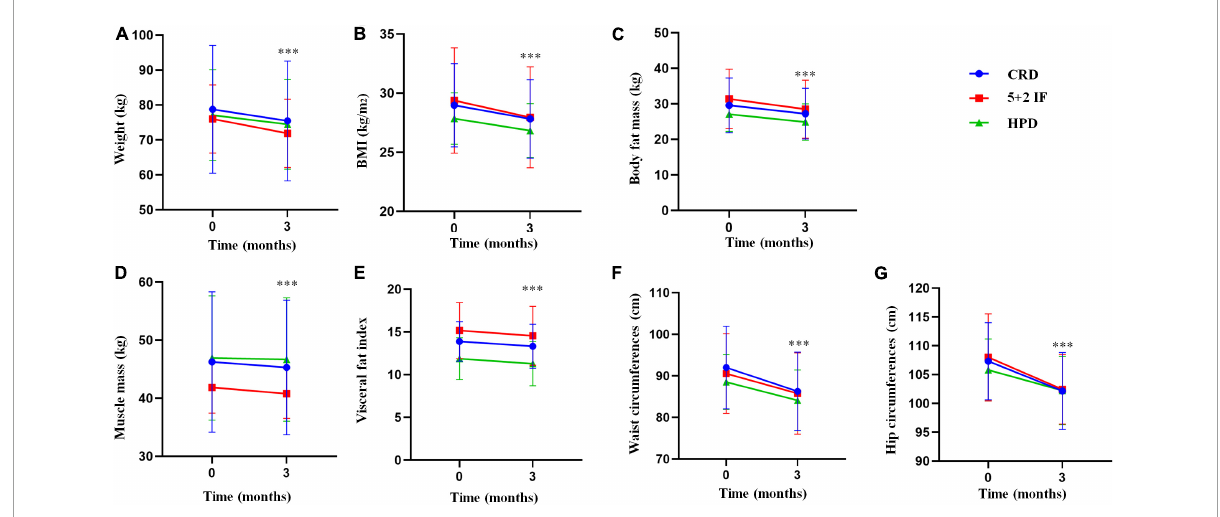
FIGURE1 Results of body composition and body mass index (BMI) among the treatment and control groups. 5 + 2 IF, 5 + 2 intermittent fasting; BMI, body mass index; CRD, calorie-restricted diet; HPD, high protein diet; SE, standard error. The figure shows the level of body composition before and after three weight management methods by mean ± standard deviation [ (A) weight; (B) BMI; (C) body fat mass; (D) muscle mass; (E) visceral fat index; (F) waist circumference; (G) hip circumference], ∗∗∗ P <